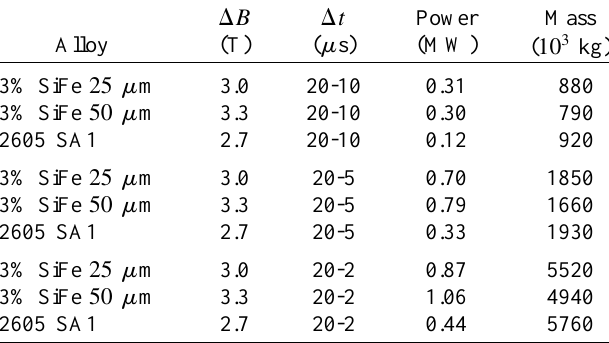
TABLE IV. Simple model of the low energy end of a power- plant driver. The higher flux swing of 3% silicon steel re- duces the mass of induction cores by 130–800 tons, at the expense of increasing the pulser power (for 5 Hz operation) by 0.18–0.62 MW. For pulse durations decreasing to 10 m s, the ion energy increases from 2 to 4 MeV; for durations to 5 m s, the beam energy increases to 8 MeV; and for durations to 2 m s, the beam energy increases to 33